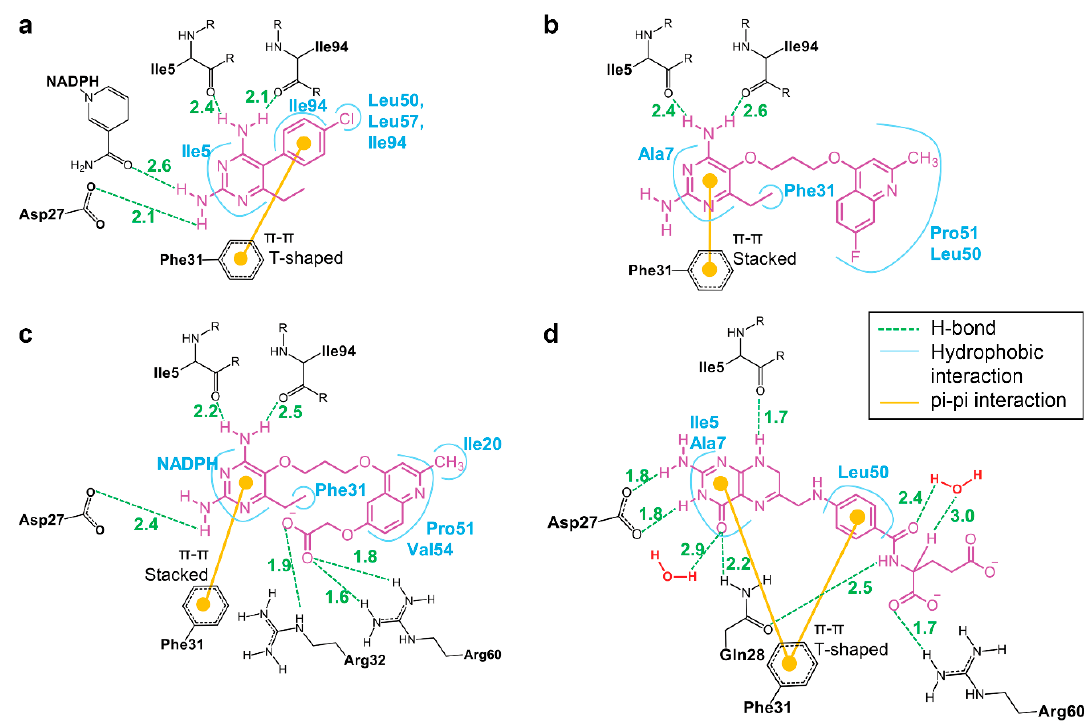
Figure 7. Interactions between amino acid residues in the mtbDHFR binding site with the ligands: ( a ) P1; ( b ) P157; ( c ) P169; and ( d ) DHF from the MD simulations. The distances (in Å) of hydrogen bonds are represented by green dashed lines. The aromatic ( π - π ) interactions are represented by yellow lines, and the hydrophobic interactions are represented by blue lines. Sci. Pharm. 2017 , 85 , 30